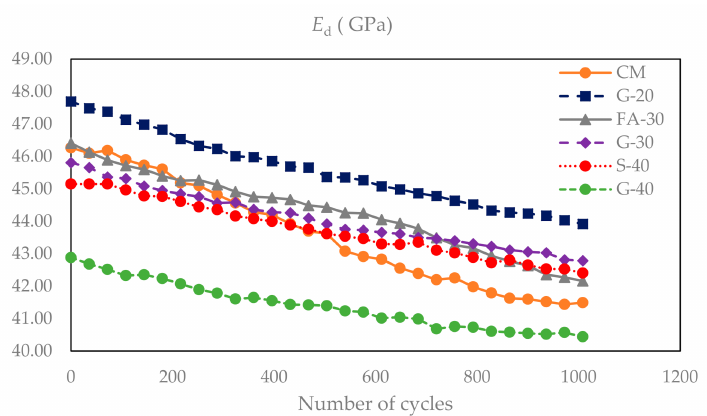
Figure 8. Dynamic modulus of elasticity as a function of number of freeze–thaw cycles.